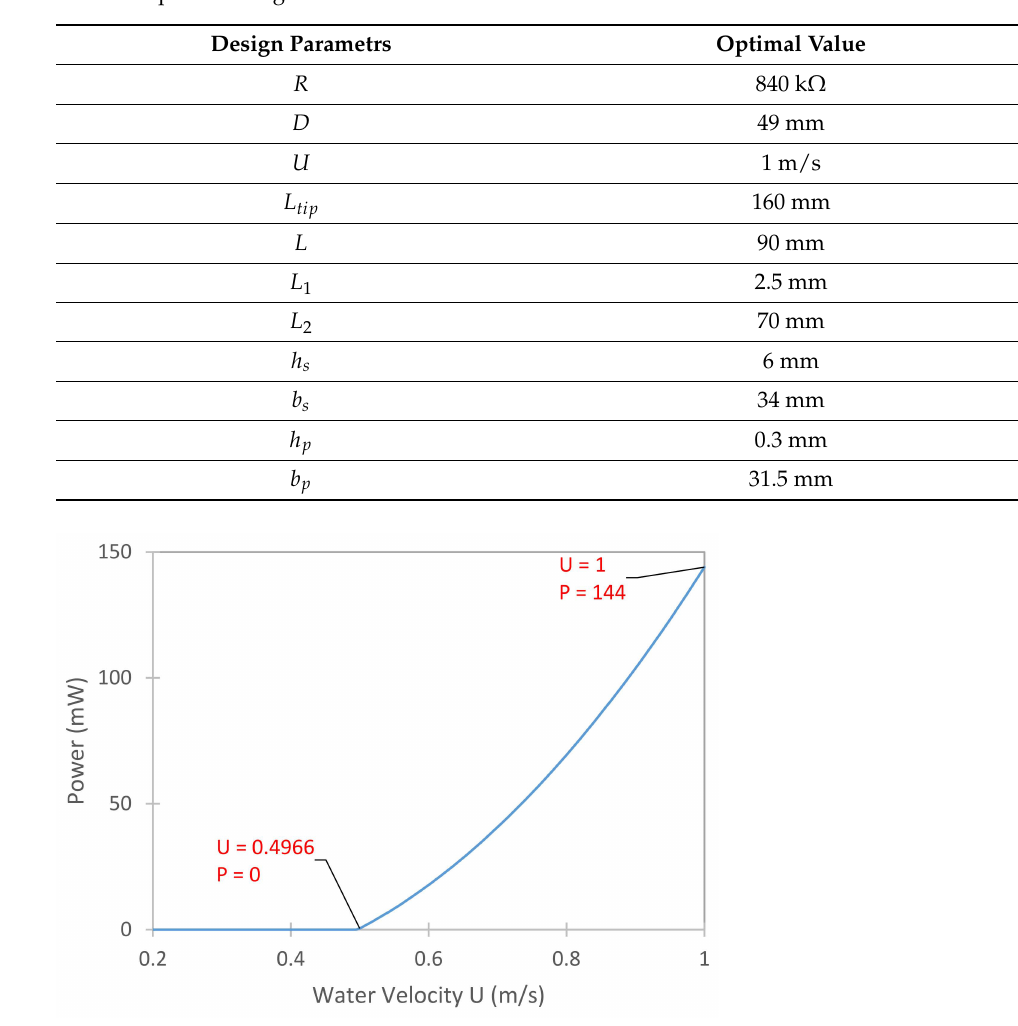
Table 2. Optimal Design Parameters.